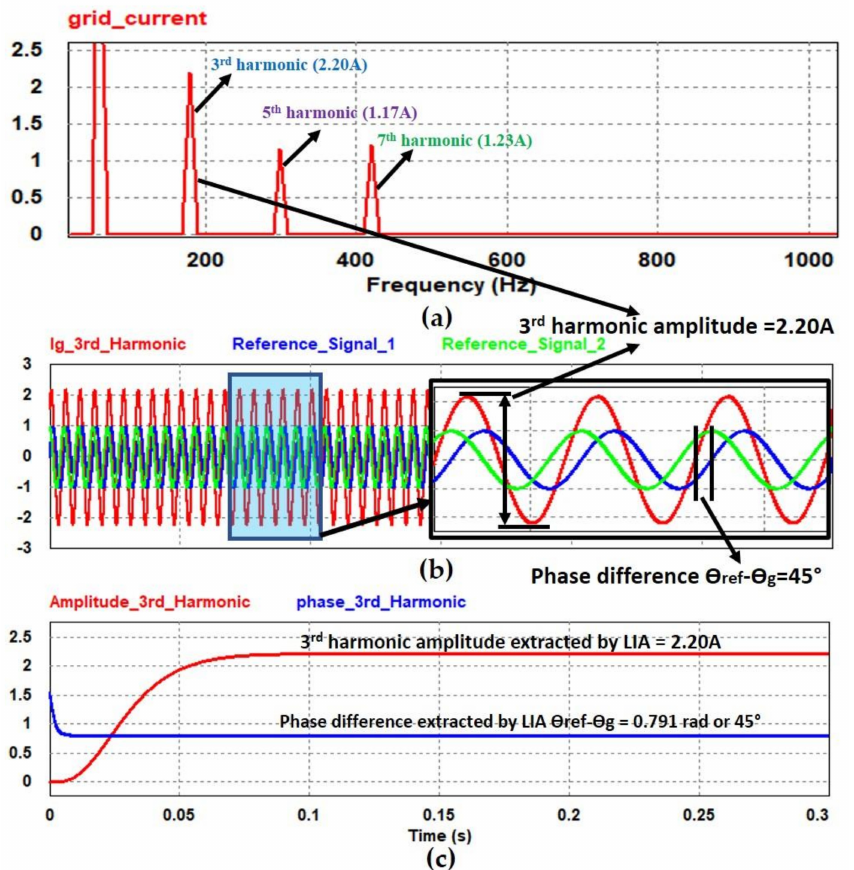
Figure 5. The amplitude and phase of the grid harmonic current extracted by LIA with reference frequency ( a ) FFT of the grid current ( b ), 3rd harmonic and arbitrarily reference signals ( c ) phase and amplitude of the 3rd harmonic current by LIA.